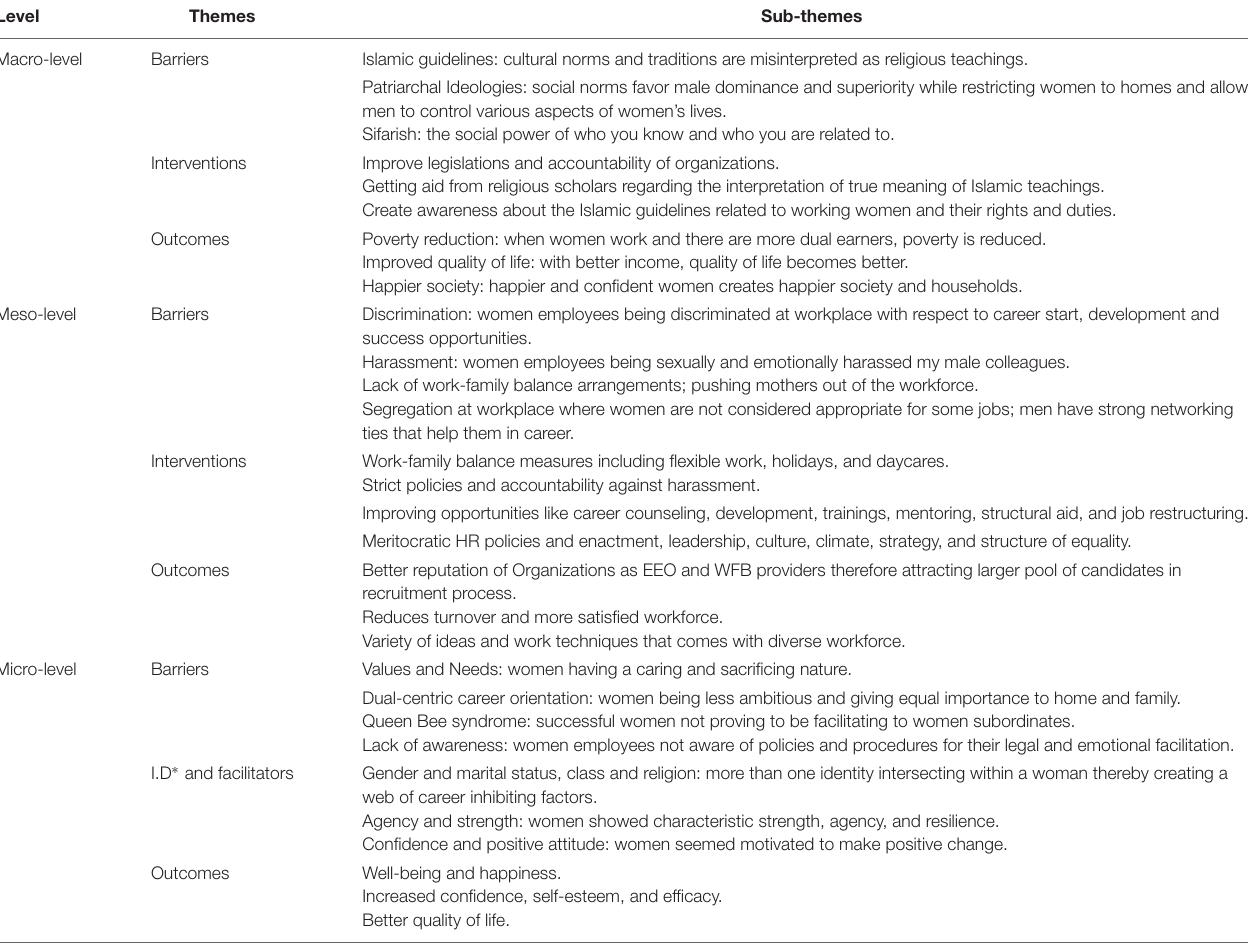
TABLE 2 | Themes and subthemes identified in data on three